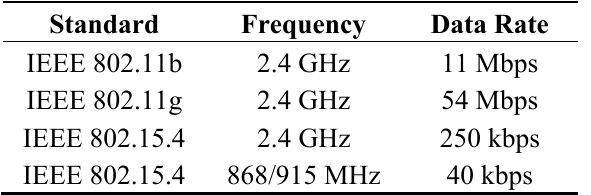
Table 1. Comparison of different wireless